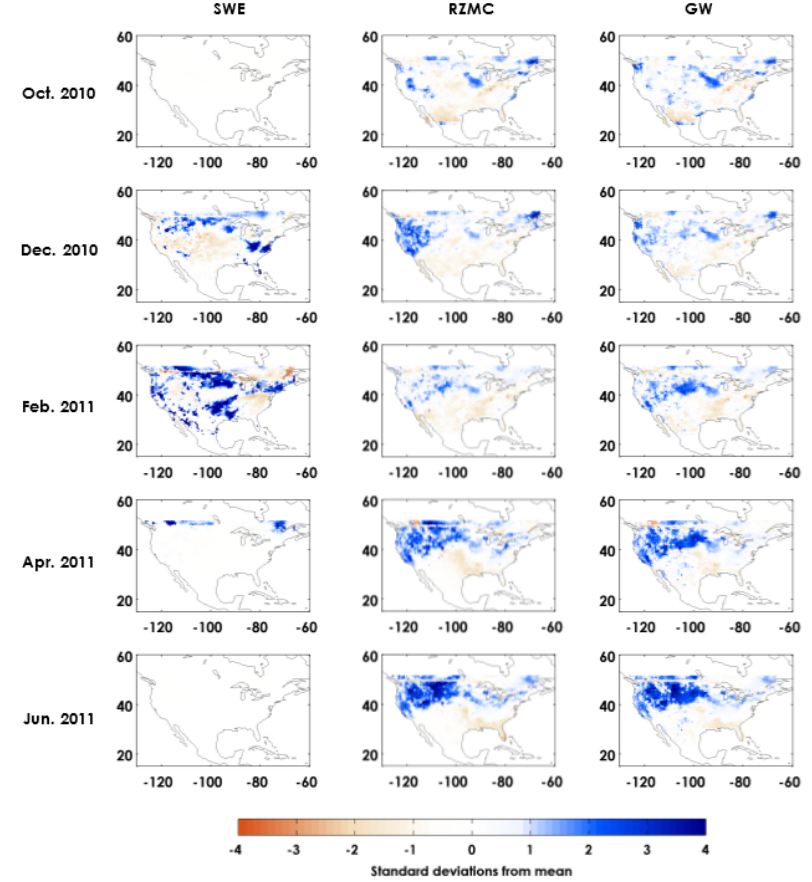
Figure 6. Time progression of the 2011 flood event, showing ( left ) snow water equivalent; ( middle ) root-zone soil moisture; and ( right ) groundwater from the CLSMDA simulation for October 2010 through June